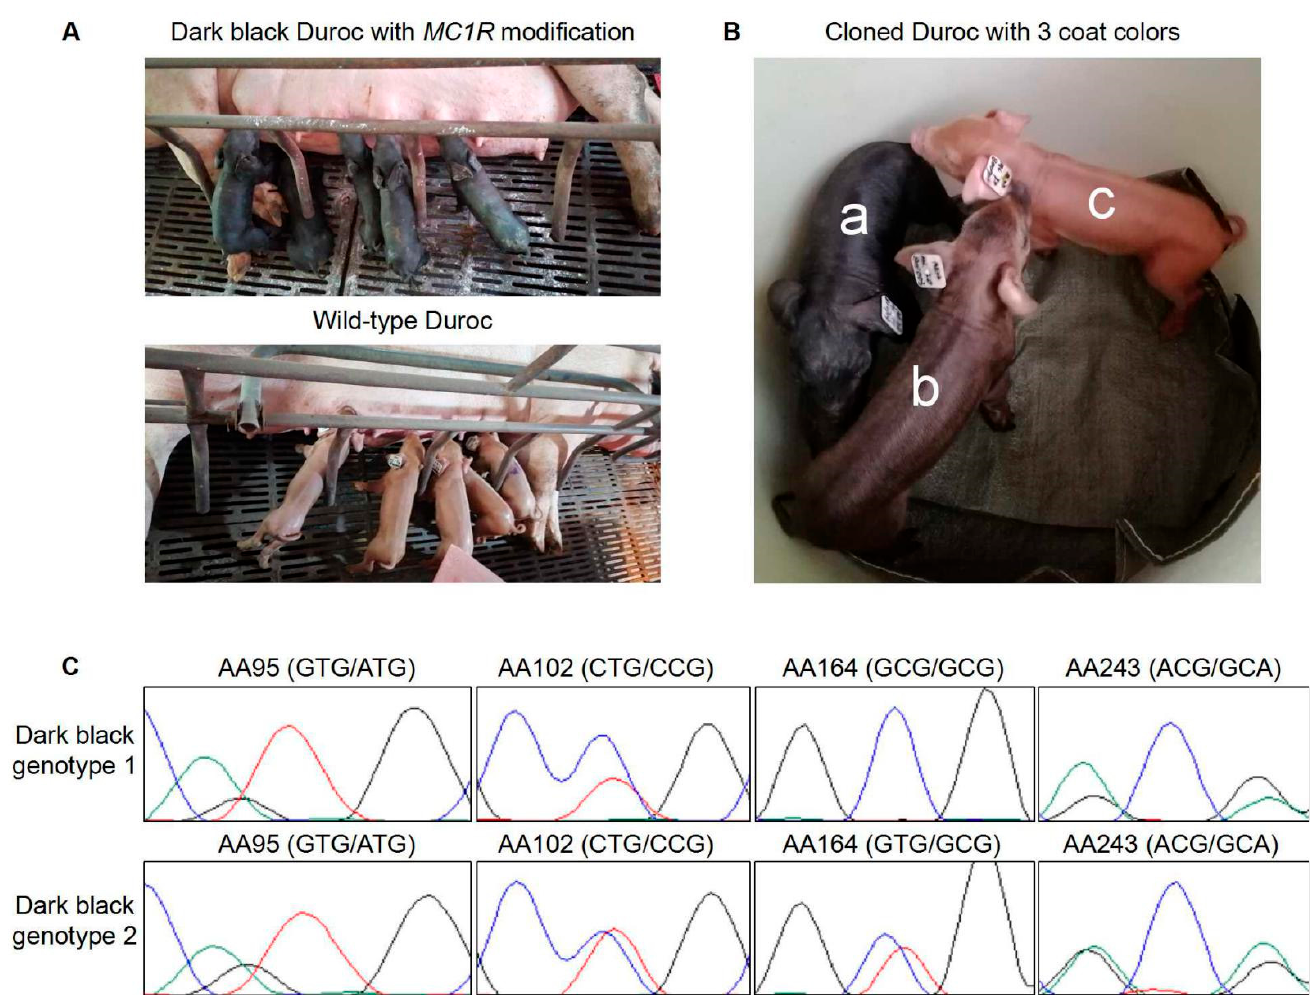
Figure 2. Blackish Durocs generated by MC1R gene editing. ( A ). The newborn MC1R -modifed Duroc pigs with the dark black coat color (upper panel). As the control, the newborn wild-type Durocs with the red coat color are shown (lower panel). ( B ). The cloned MC1R -modified piglets displayed three types of coat color: dark black ( a ), light black ( b ), and wild-type red ( c ). Total substitution in four SNP sites (in one allele or both alleles) resulted in coat color switch in Durocs ( a and b ). Light black pigs ( b ) harbored an intact substituted MC1R allele, but its expression was lower than the same substituted allele in the dark black pigs ( a ). Expression level of the substituted MC1R allele may decide the black color depth. Non-modification or knockout of the MC1R e allele generated the red coat color ( c ). ( C ). Sanger sequencing results showed that all four SNPs were substituted with corresponding E D1 genotypes on at least one MC1R allele in dark black pigs. Among them, nine had the four SNPs substituted on only one allele (dark black genotype 2), and eight had three SNPs substituted on one allele and one SNP substituted on both alleles (dark black genotype 1). AA, amino acid position.